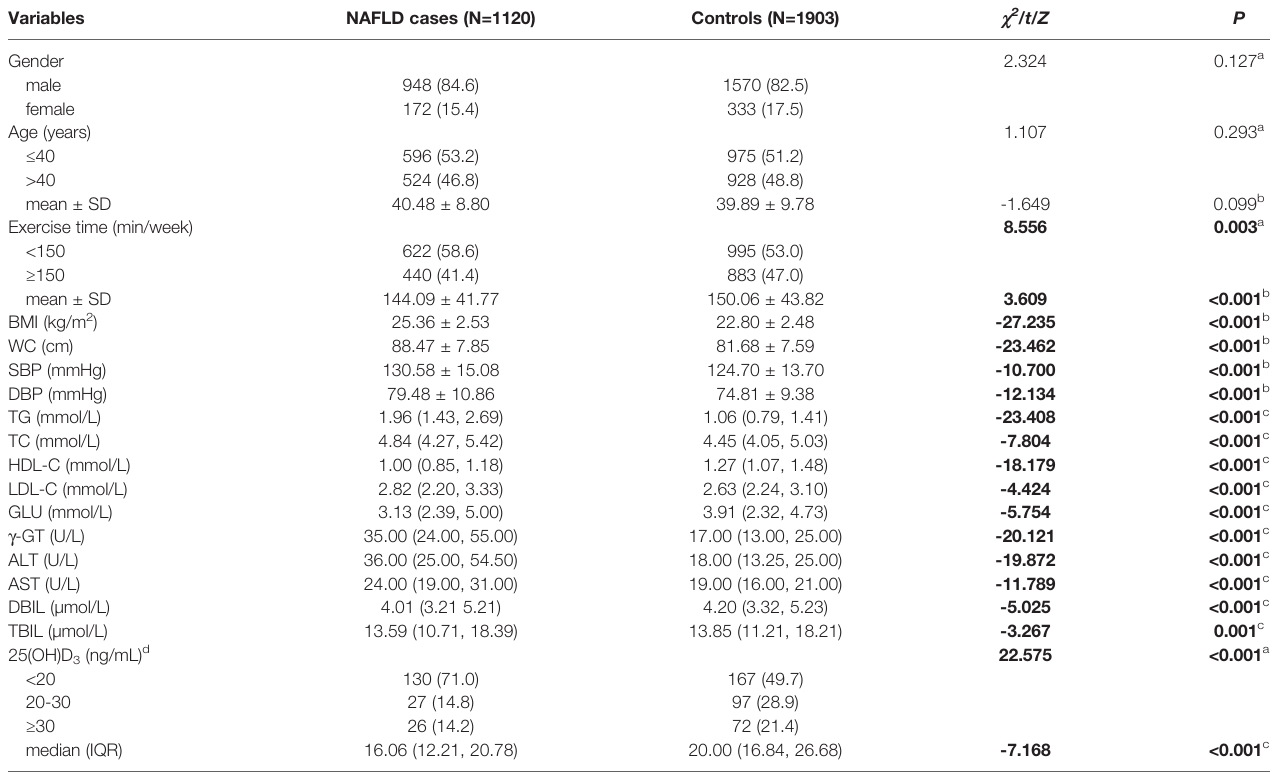
TABLE 1 | Distributions and comparisons of demographic and clinical characteristics between NAFLD case and control groups.